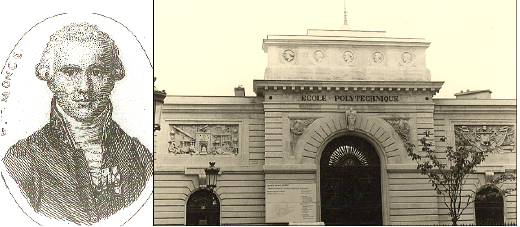
Figure 9 . Gaspard Monge (1746-1818) Creator of the École Polytechnique, and the main building of the École Polytechnique in Paris (established in